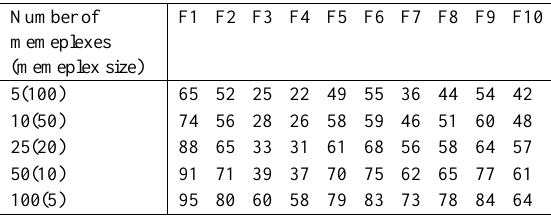
Table 7. Number of successful runs for different memeplex size. The total number of frogs is fixed and is equal to 𝟓𝟎𝟎 .